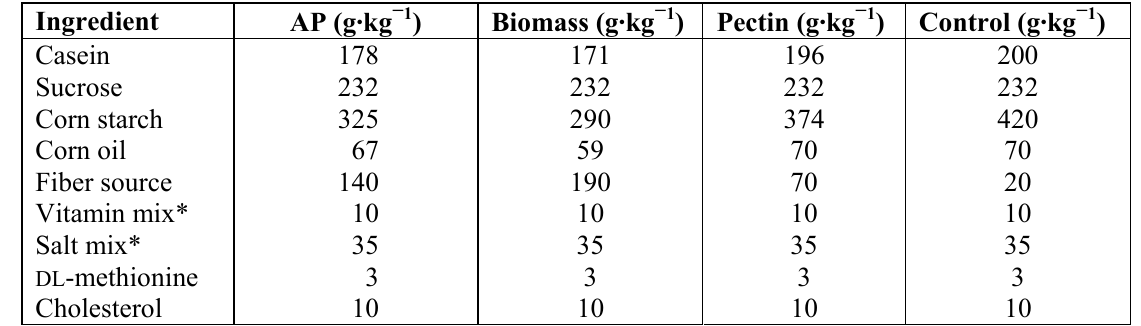
Table 2. Composition of experimental